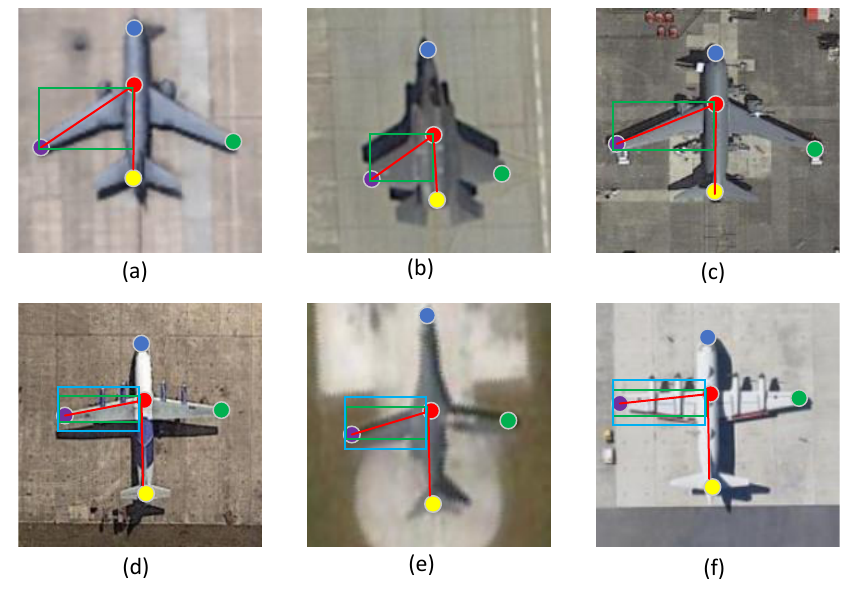
Figure 6. Two ways to crop